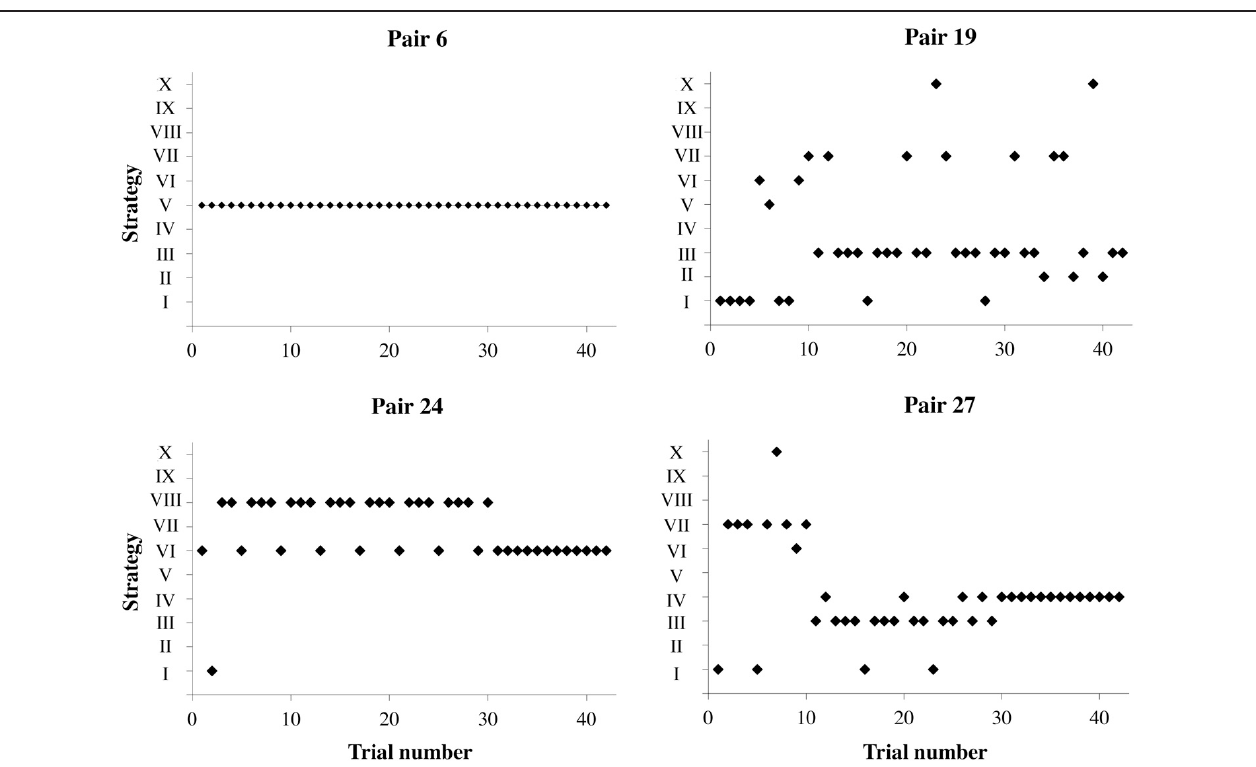
FIGURE 5 | The different strategies used by four pairs with respect to the NEW problem. The Roman numerals indicate different strategies, as described in the main text.